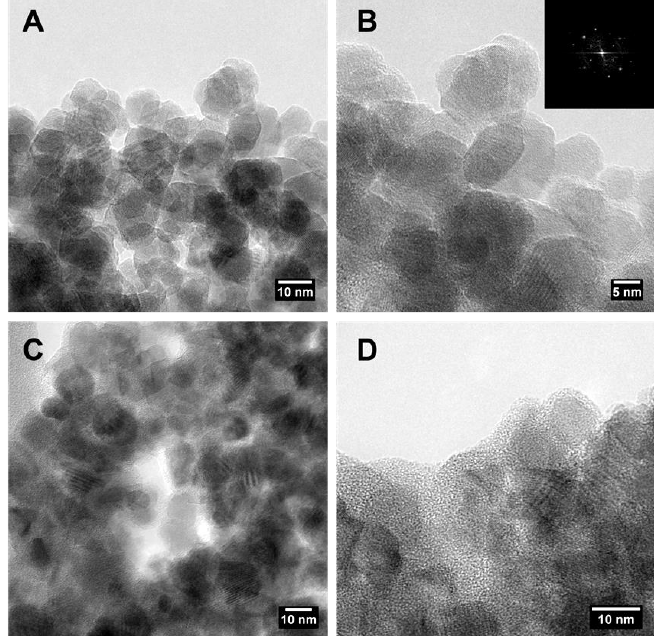
Figure 2. Representative transmission electron microscopy (TEM) micrographs of the obtained particles: ( A , B ) magnetite nanoparticles; ( C , D ) magnetite-activated carbon nanocomposite. The inset in ( B ) shows the Fourier transform of the electron diffraction pattern, demonstrating the crystallinity of magnetite nanoparticles.